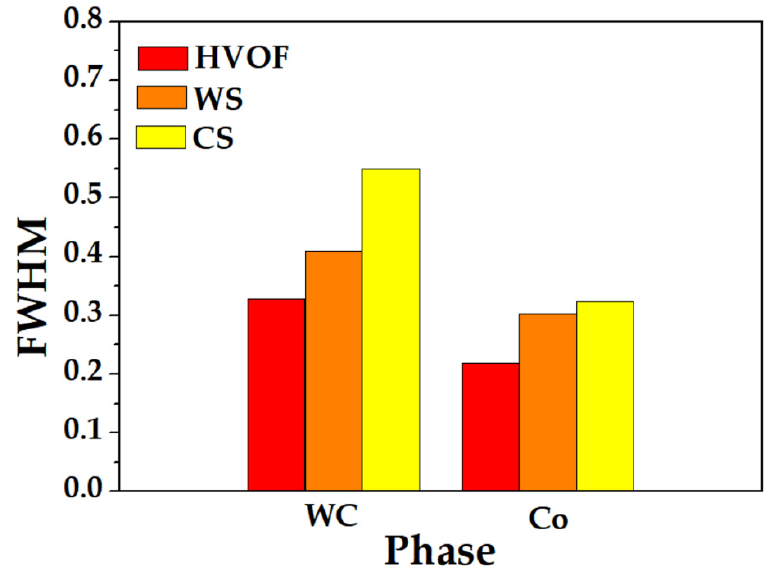
Figure 10. Full widths at half maximum (FWHMs) of WC and Co in WC-17Co coatings formed in various spraying ways.